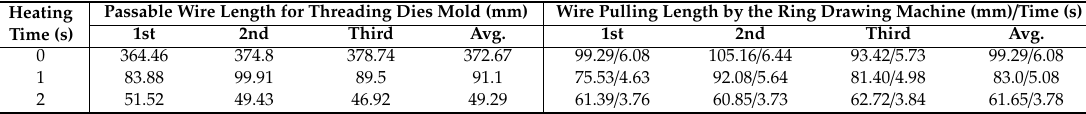
Table 9. Results based on wire pulling speed: k9(16.32 mm / s).